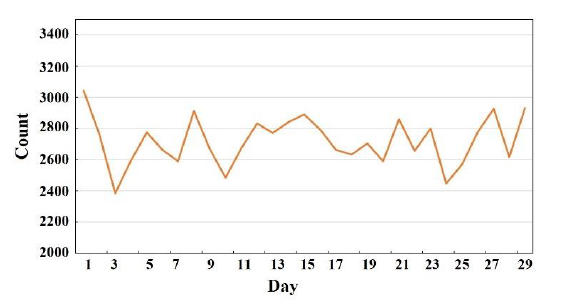
Figure 6. The number of emergency travels in a month.